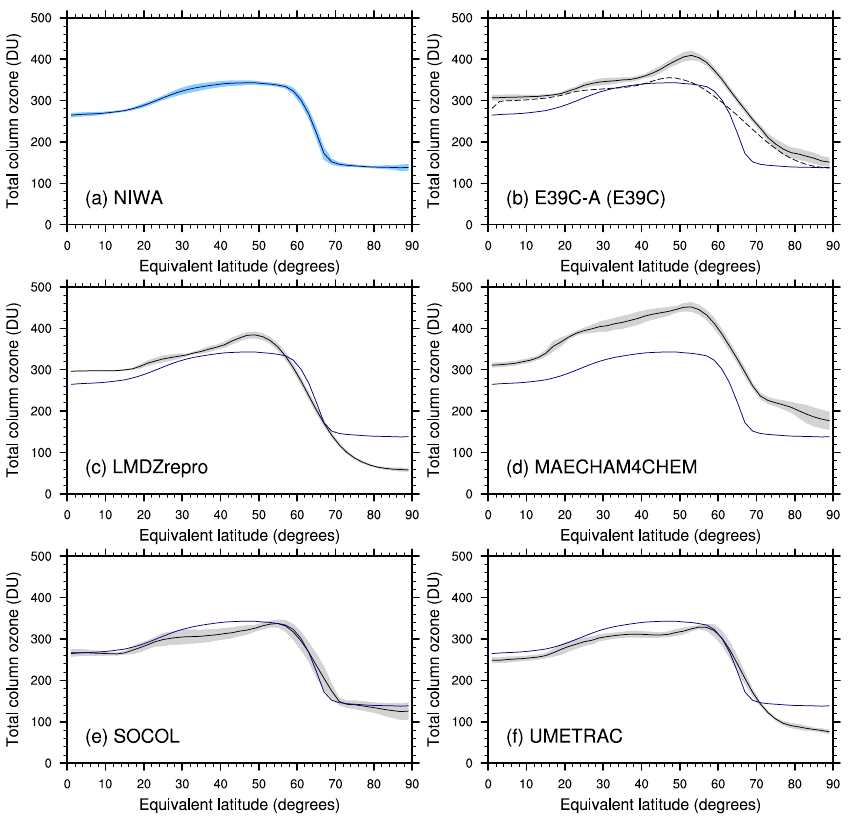
Fig. 4. Five year (1995–1999) average October total column ozone from (a) NIWA combined total column ozone data-base and (b) E39C-A (dashed line E39C), (c) LMDZrepro, (d) MAECHAM4CHEM, (e) SOCOL and (f) UMETRAC. Shading indicates the 1 σ standard deviation about the mean. The blue lines are the observed mean overlaid on the model results for comparison. 30